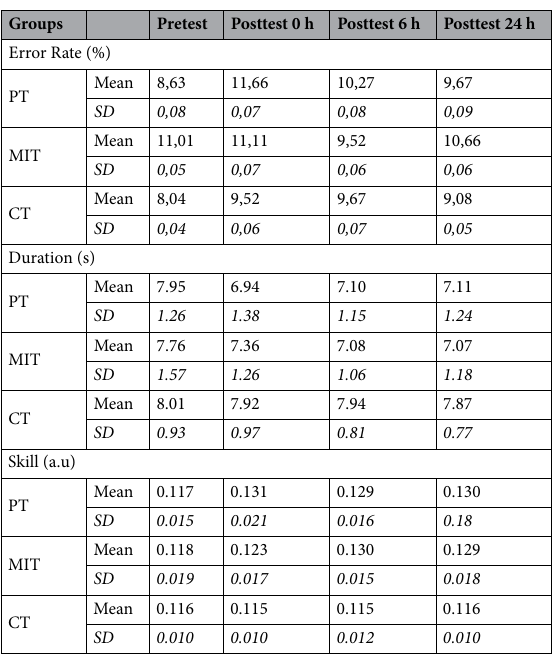
Table 1. Average values (+ SD) of Error Rate (%), Duration (s) and Skill (a.u.) at Pretest, Posttest 0 h, Posttest 6 h and Posttest 24 h for all groups for the main experiment (PT: Physical Training Group, MIT: Motor Imagery Training group, CT: Control Training group).